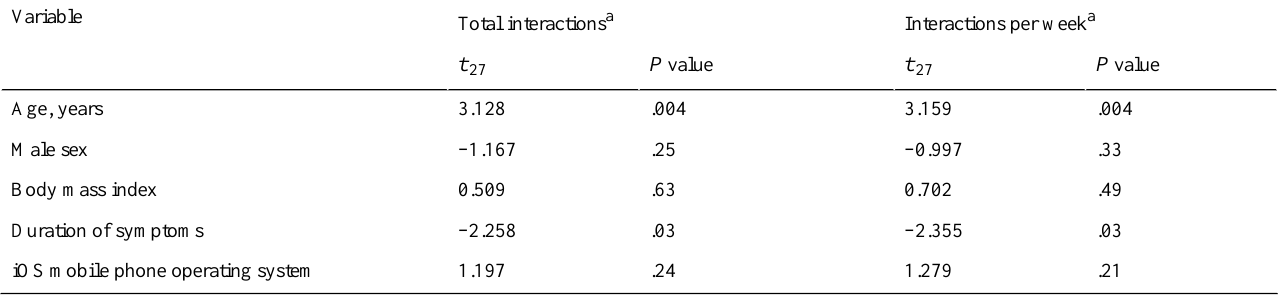
Table 2. Associations between participant characteristics and program interaction measures (N=35).